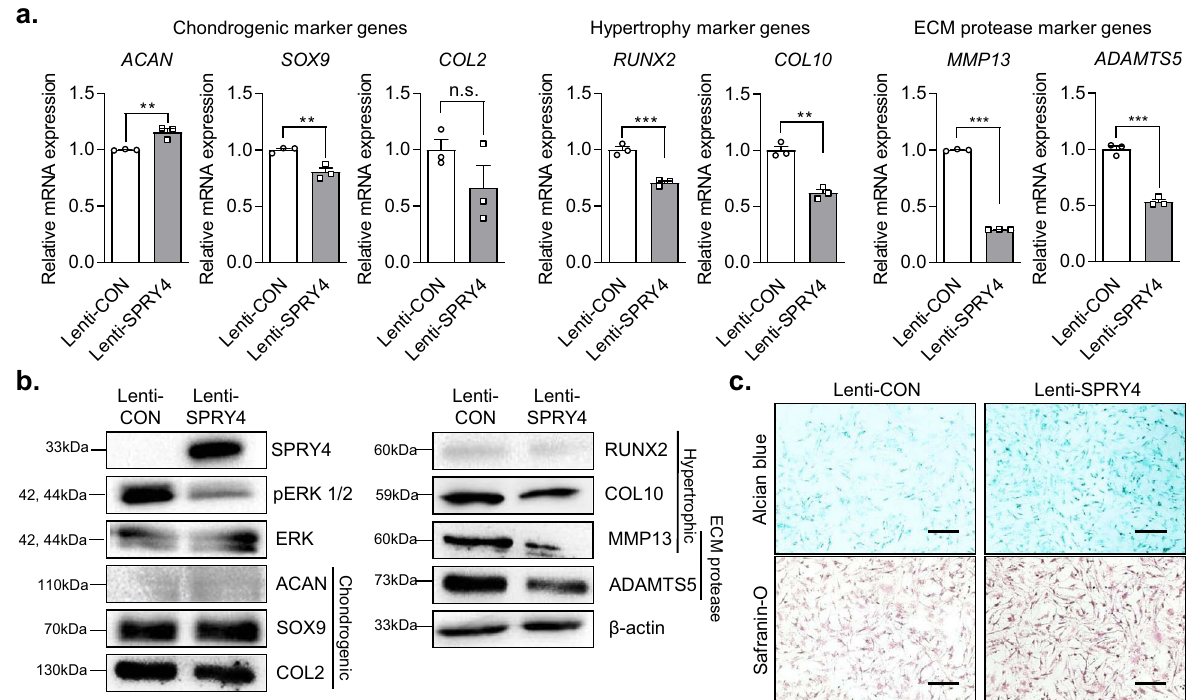
Fig. 5 Effect of SPRY4 overexpression on OA-related biological properties of DCs. a mRNA expression analysis of various chondrogenic, hypertrophic, and ECM protease markers in Lenti-CON-treated and Lenti- SPRY4 -treated DCs. The data represent the mean ± SEM ( n = 3; ACAN and MMP13: unpaired t -test; SOX9, COL2, RUNX2, COL10, and ADAMT5: unpaired t -test with Welch ’ s correction). b Western blot protein analyses of various chondrogenic, hypertrophic, and ECM protease markers in Lenti-CON-treated and Lenti- SPRY4 -treated DCs. c Alcian blue and Safranin-O staining of Lenti-CON-treated and Lenti- SPRY4 -treated DCs. Scale bars, 200 μ